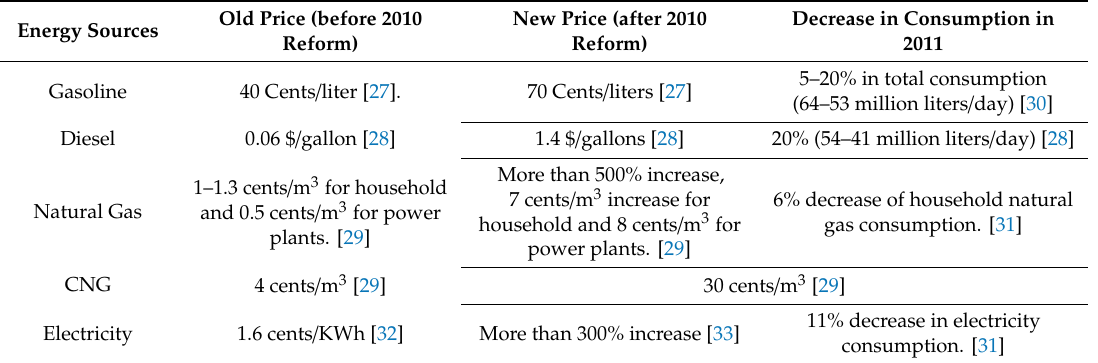
Table 3. Energy subsidies in Iran and new prices reform impact on consumption decrease. [27–29].